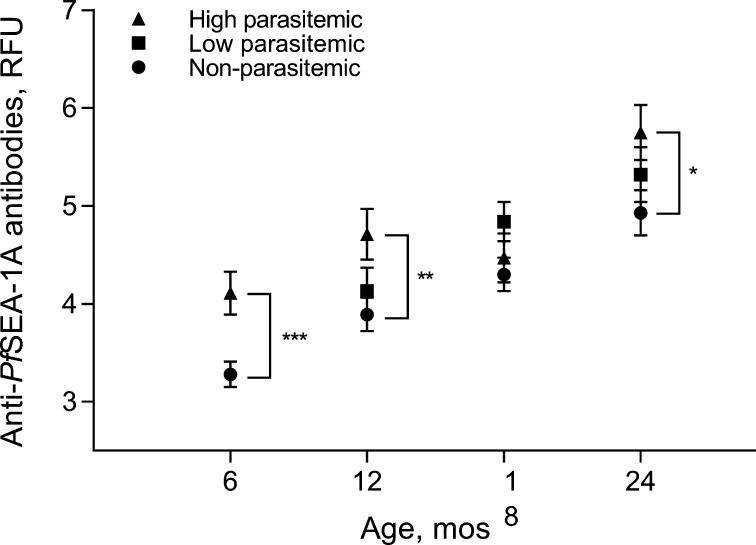
Effects of parasitemia for 6 months prior on anti-PfSEA-1A antibody levels. At 6 months, infants were grouped into parasitemic and non-parasitemic, because of low prevalence of parasitemia (30.6%). At later time points, infants were grouped into tertiles of parasitemia. Anti-PfSEA-1A antibody levels were natural log-transformed. Error bars represent 95% confidence intervals. *P < 0.05, **P < 0.01, and ***P < 0.001.